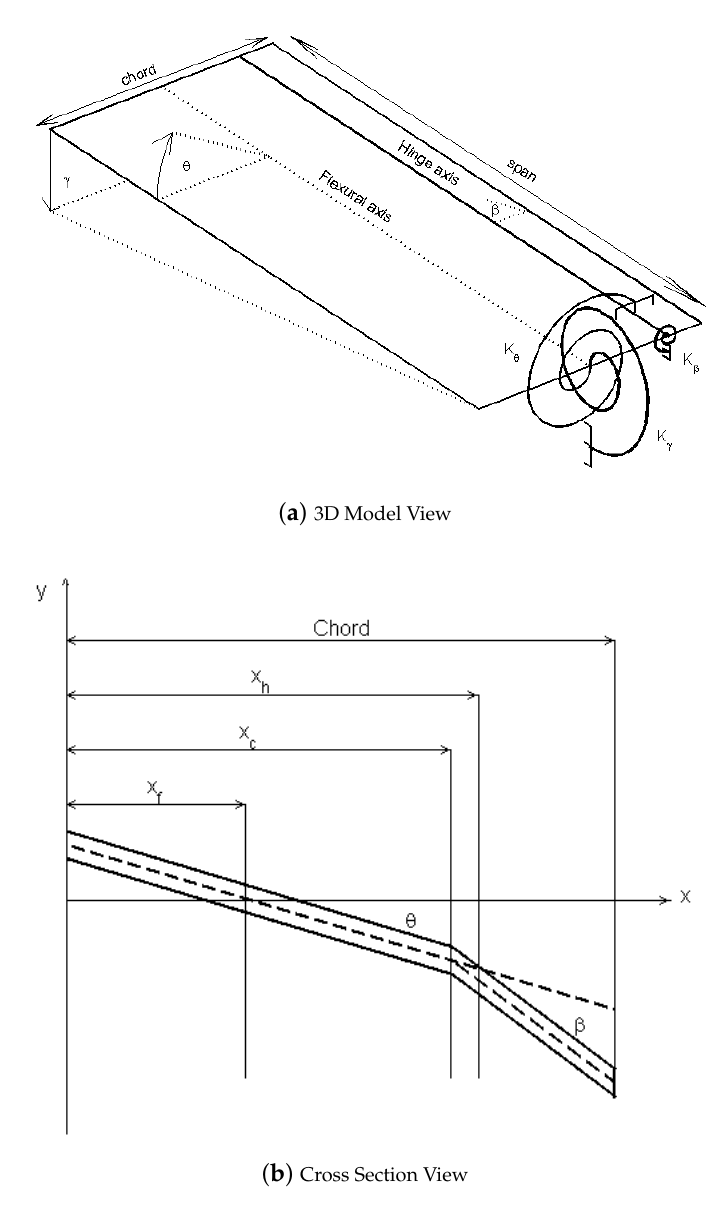
Figure 1. Hancock wing